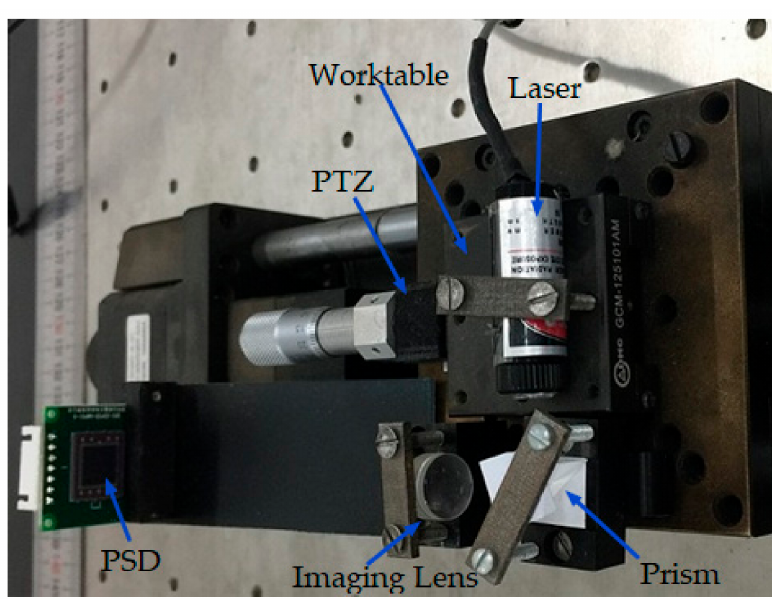
Figure 4. Photograph of the PSD displacement detection